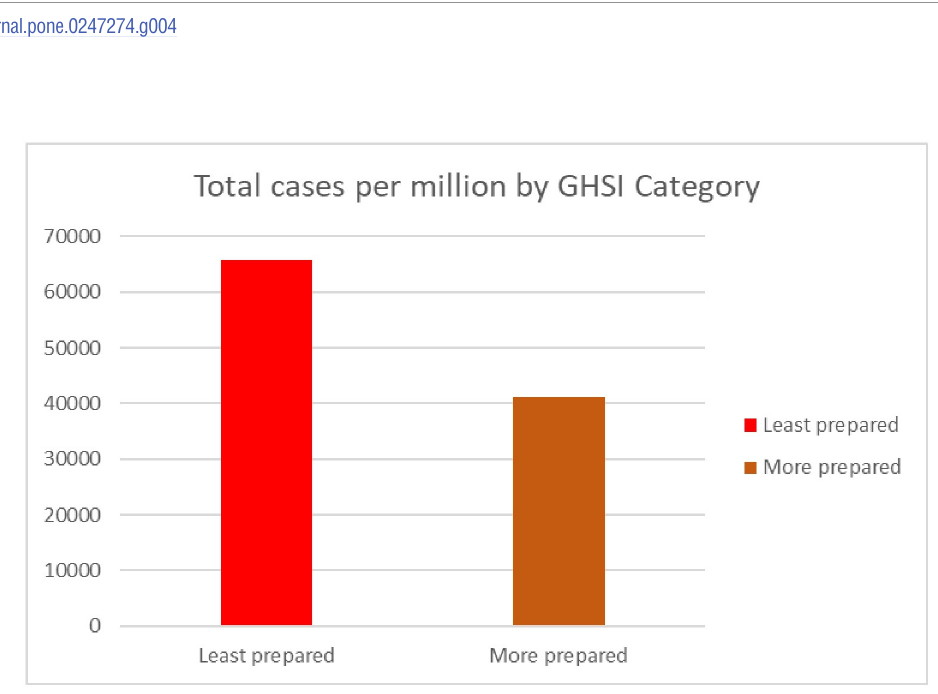
Fig 5. Total confirmed positive cases by GHSI category.